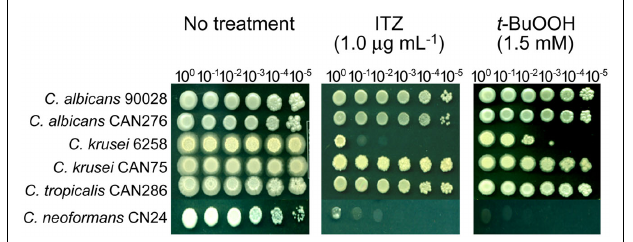
FIGURE 3 | Chemosensitization of itraconazole (ITZ) by salicylaldehyde (SA). (A) Scheme for chemosensitization of ITZ by SA. For control, DMSO was used. (B) Fungal plate bioassay showing combined treatment of SA (37.5–45.0mM, spotted onWhatman™filter paper) and ITZ [2–3 μ gmL − 1 , incorporated into Sabouraud dextrose agar (SDA) medium] completely inhibited the growth of Aspergillus fumigatus AF293, while individual treatment of each compound, alone, at the same concentrations allowed the growth of fungi.